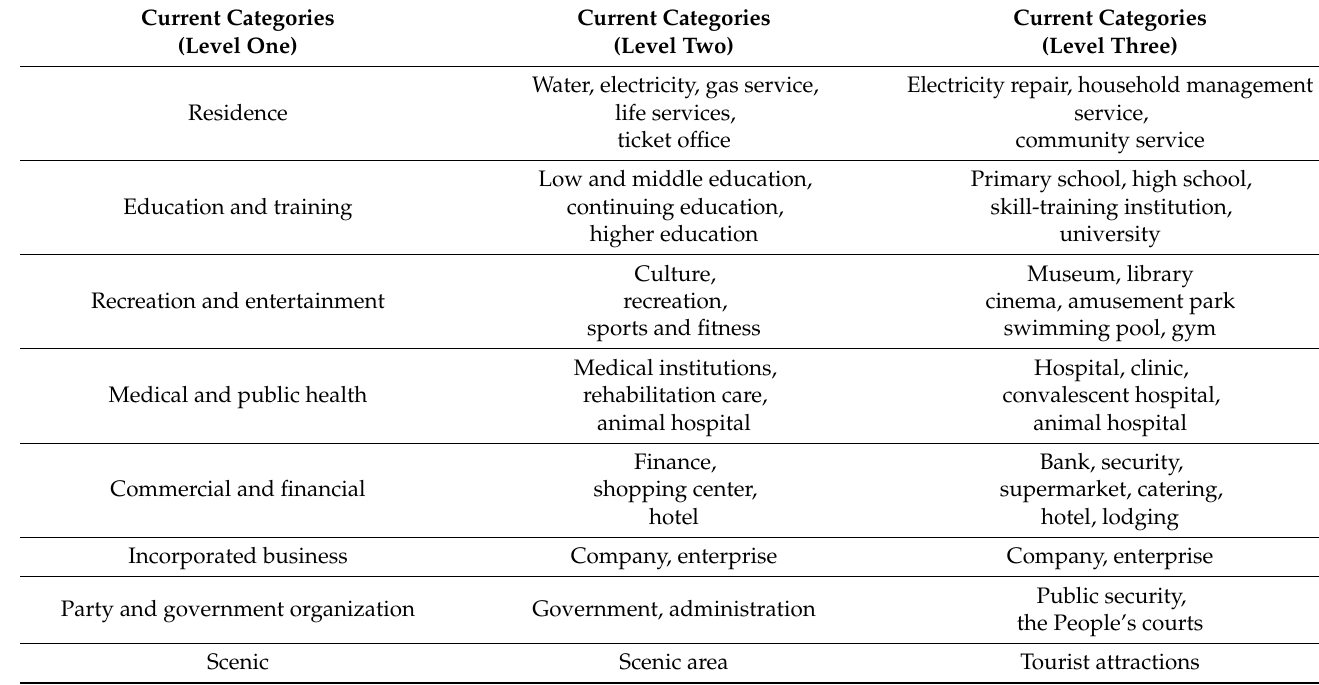
Figure 2. Maps of the study area ( a ) Xicheng District, Beijing; ( b ) division of the Xicheng District into 15 blocks: Baizhifang Street, Guang’an Gate Street, Guang’anmen Nei Street, Dashilan Street, Financial Street, Yuetan Street, Xi Chang’an Street, Xinjiekou Street, Shichahai Street, Zhanlan Road Street, Henderson Street, Cedrela Street, Bridge Street, Niujie Street, and Taoranting Street. Table 1. Results of the reclassification of POI